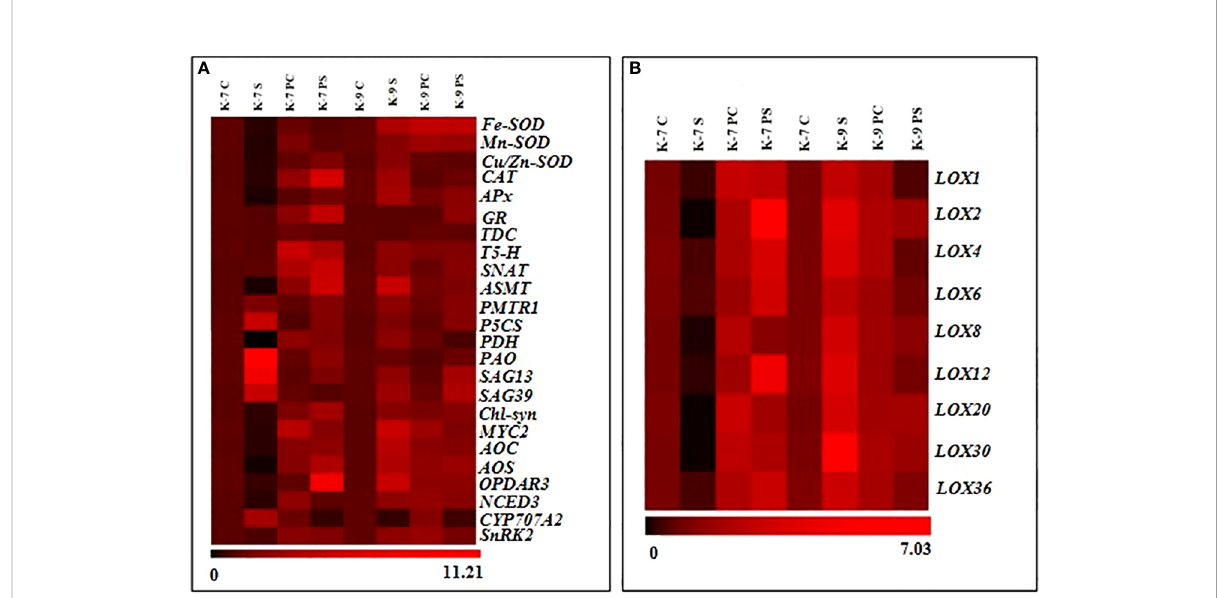
FIGURE 12 Relative abundance of mRNA transcripts of genes (fold-change in comparison to control plants of respective variety) associated with (A) antioxidant, melatonin biosynthesis and receptor, chlorophyll degradation and biosynthesis, JA biosynthesis, ABA biosynthesis and degradation, and ABA response element (B) lipoxygenase isoforms in primed or unprimed plants K-7 (drought-sensitive) and K-9 (drought-tolerant) varieties, under optimal conditions (control) or drought stress.